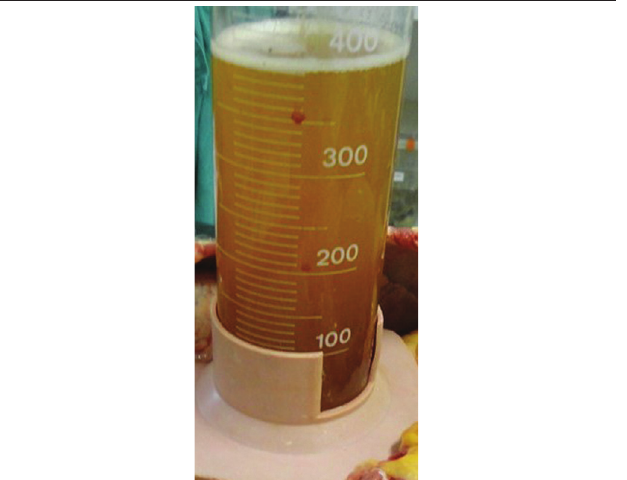
figurE 4 − Citrine-colored liquid